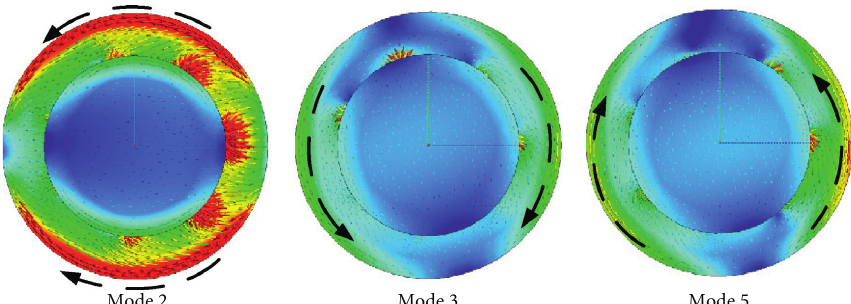
Figure 15: Modal current distribution of the antenna with seven probes at